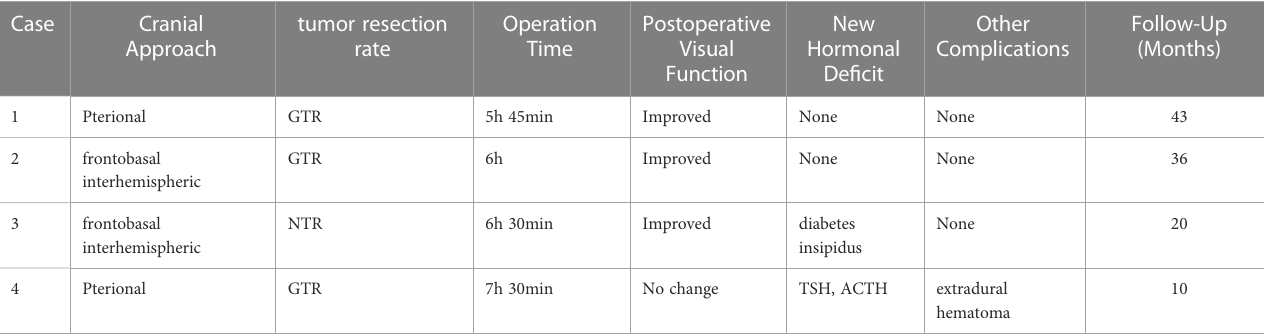
TABLE 2 Operative procedures and patient outcomes.